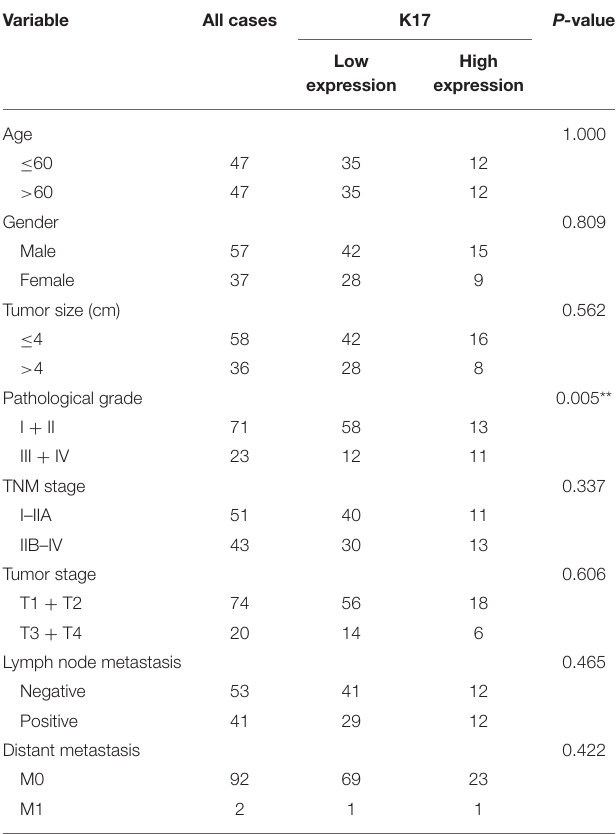
TABLE 1 | Correlations between clinicopathological characteristics and K17 expression in pancreatic cancer patients. Variable All cases K17 P-